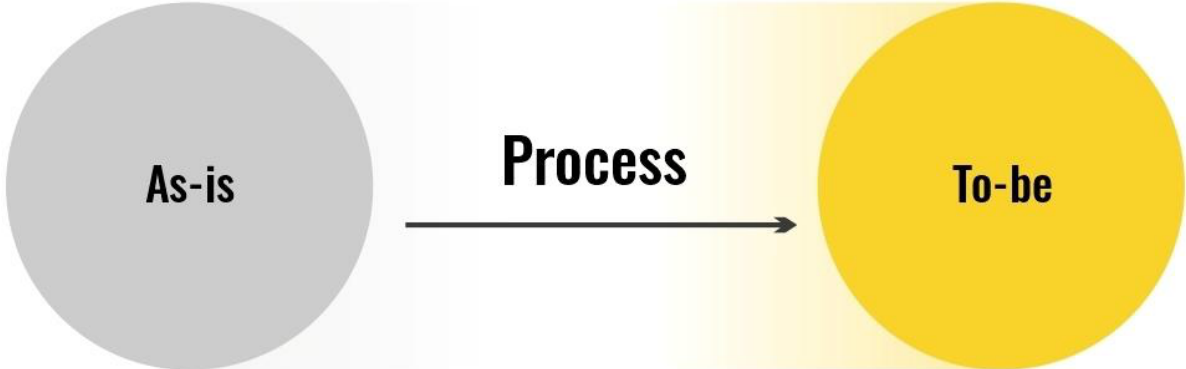
Figure 2. Processes developing from AS-IS to TO-BE (developed by the